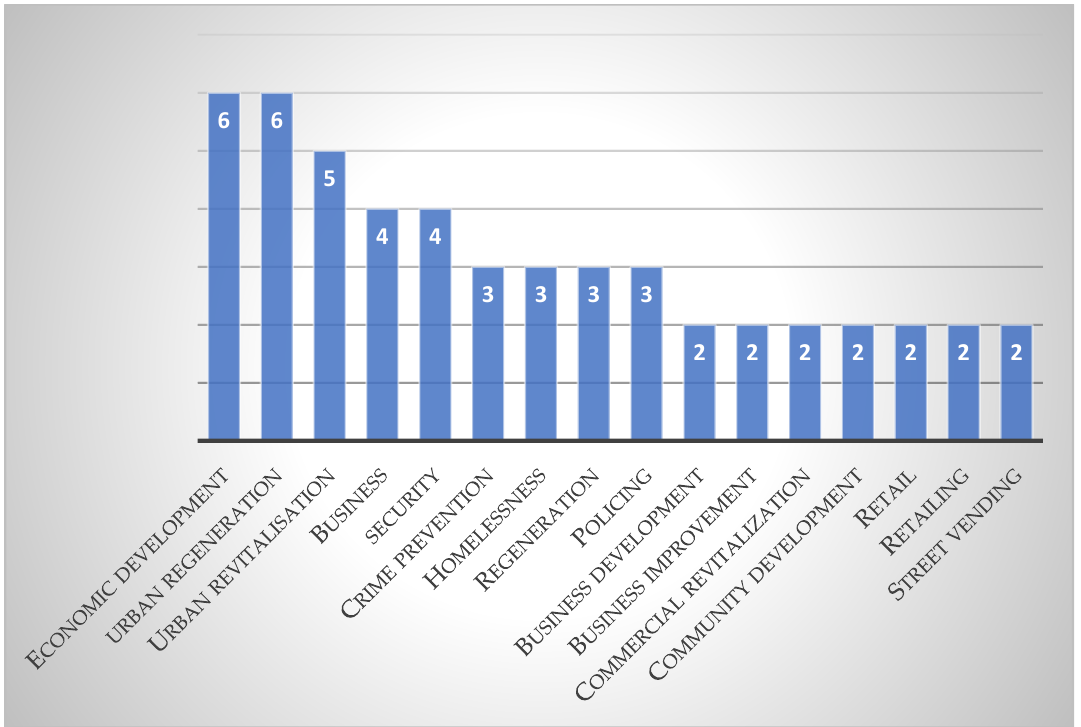
Figure 9. List of keywords from the research subject “Activities/Axis of intervention”. Source: author (2021), after initial screening and selection of publications. Note: in this figure, only keywords with two or more listings were included.